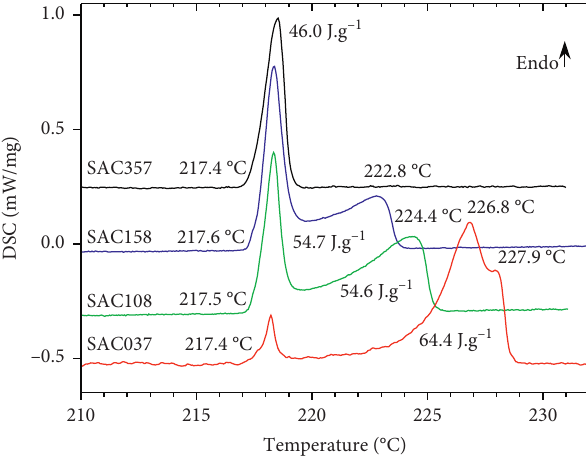
Figure 5: DSC records of the solder